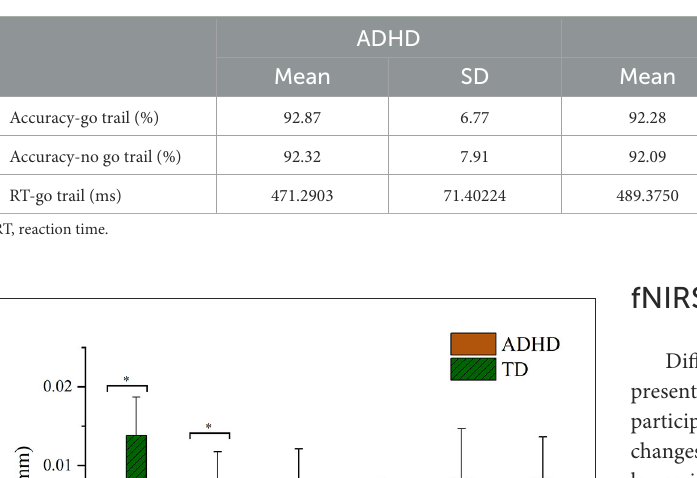
TABLE 2 Go/no-go task performance for ADHD and control groups.